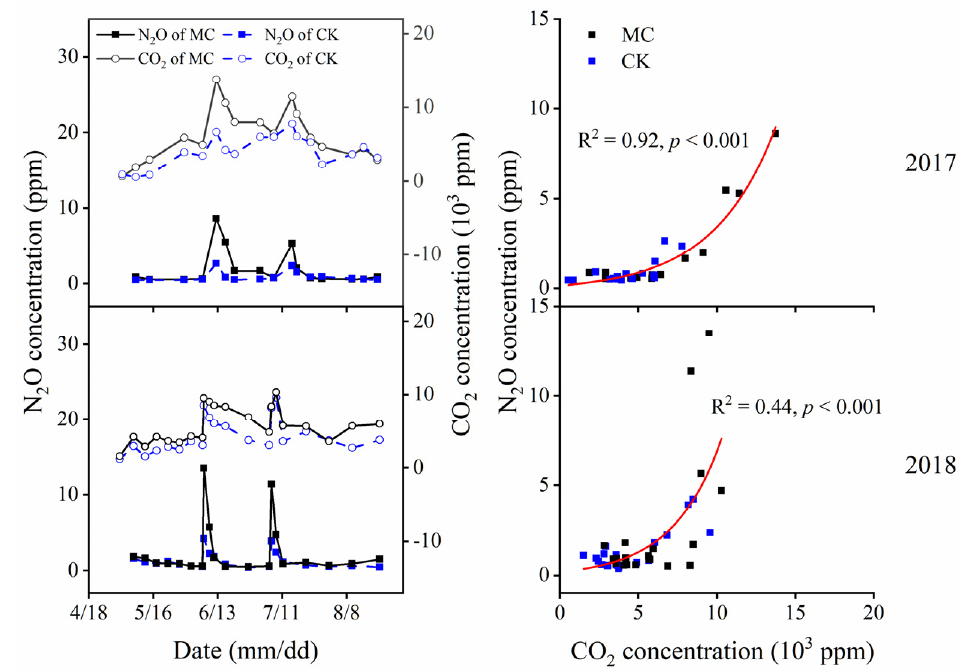
Figure 3. Variation of soil CO 2 and N 2 O concentrations in 2017 and 2018 and the relationship between soil CO 2 and N 2 O concentrations.